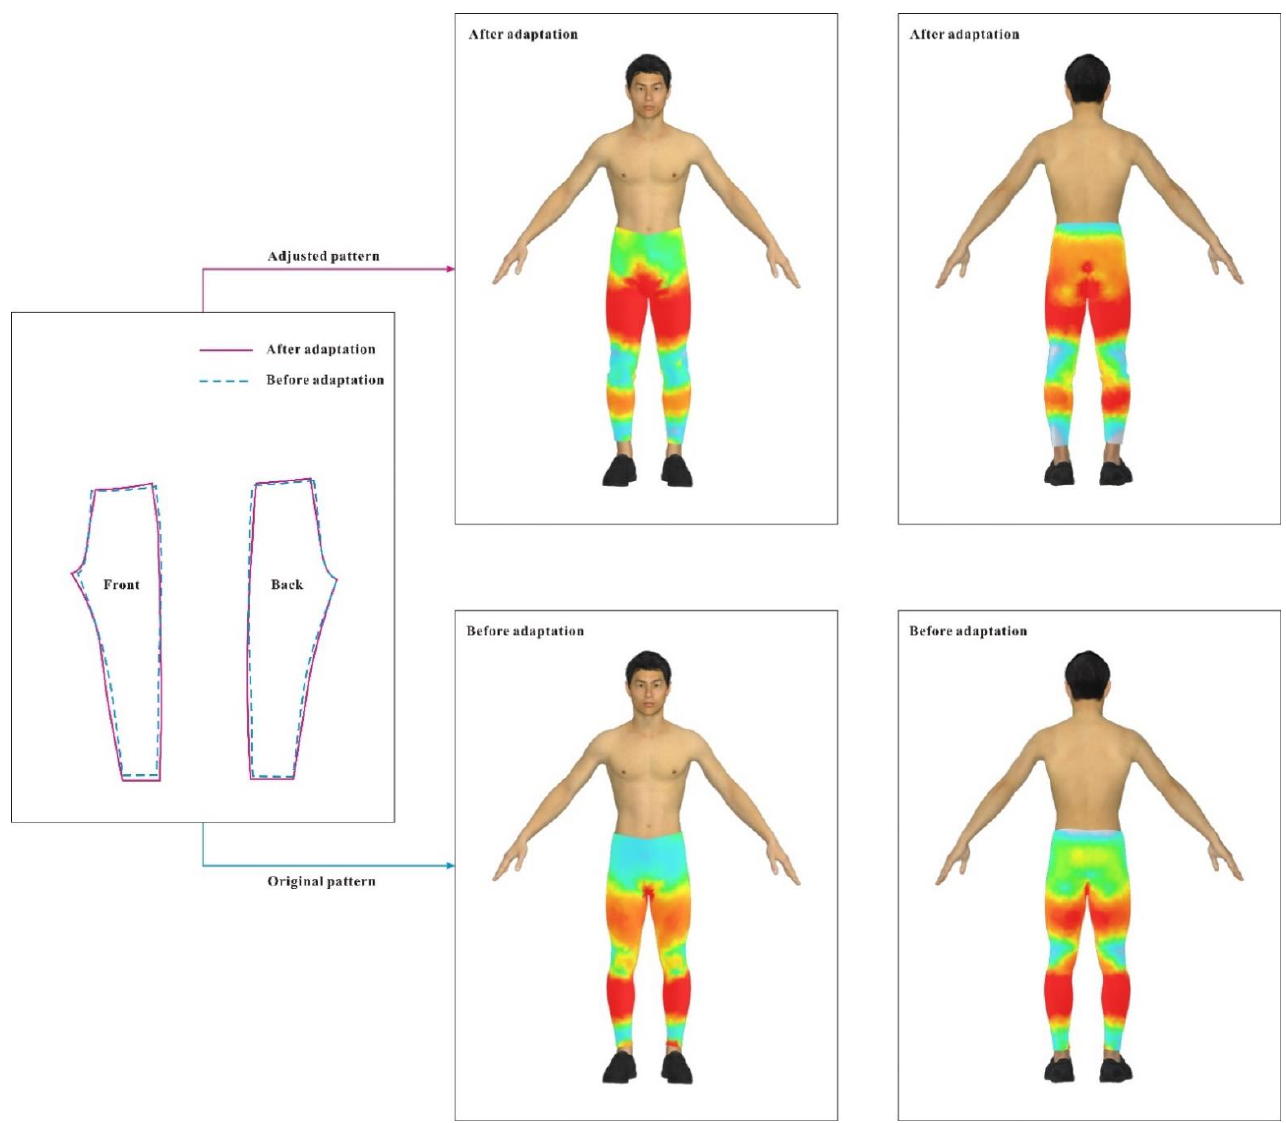
Figure 8. Comparison of the leggings patterns before and after adaptation.